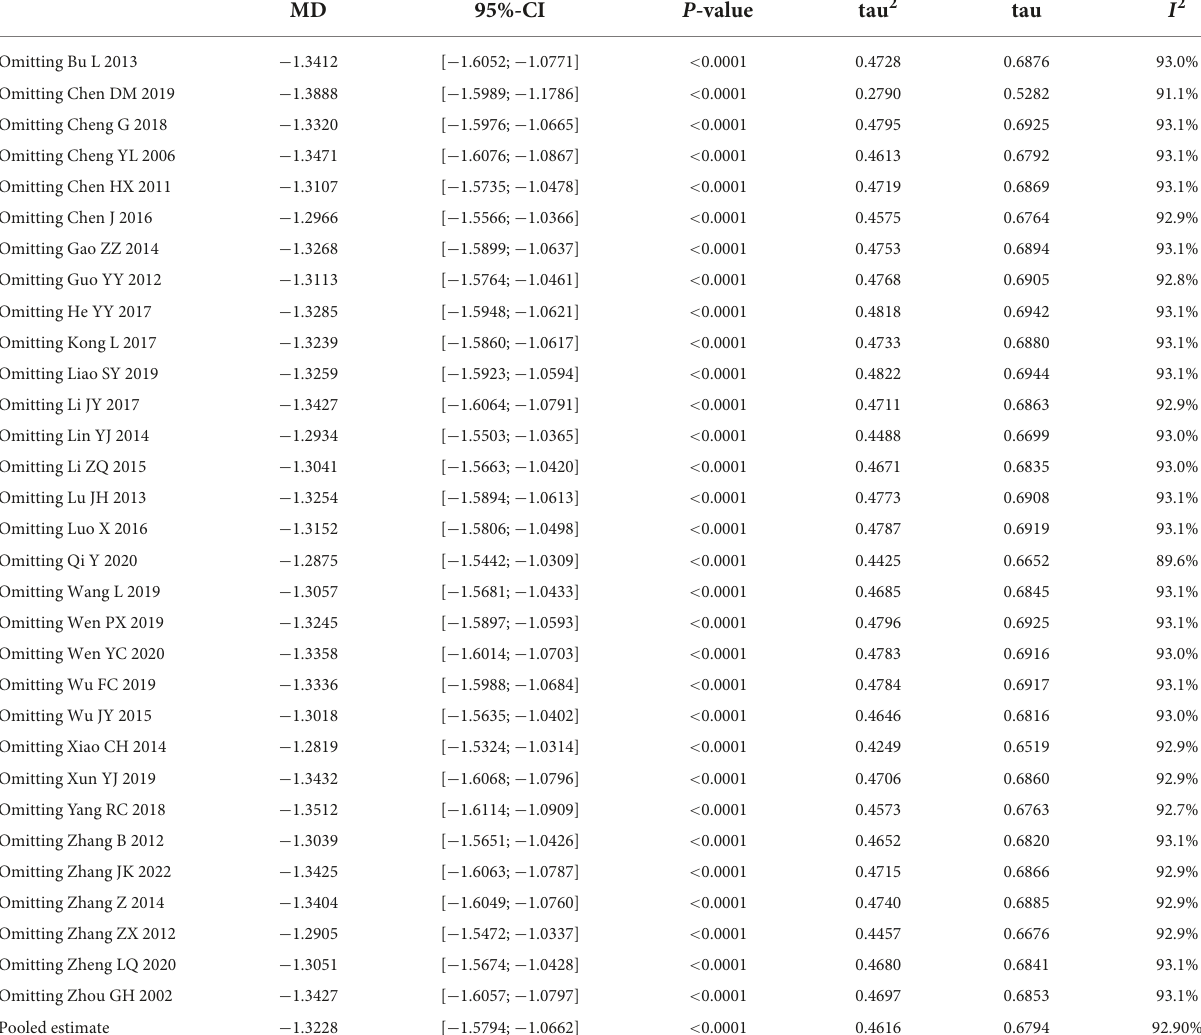
TABLE 1 Results of sensitivity analysis based on